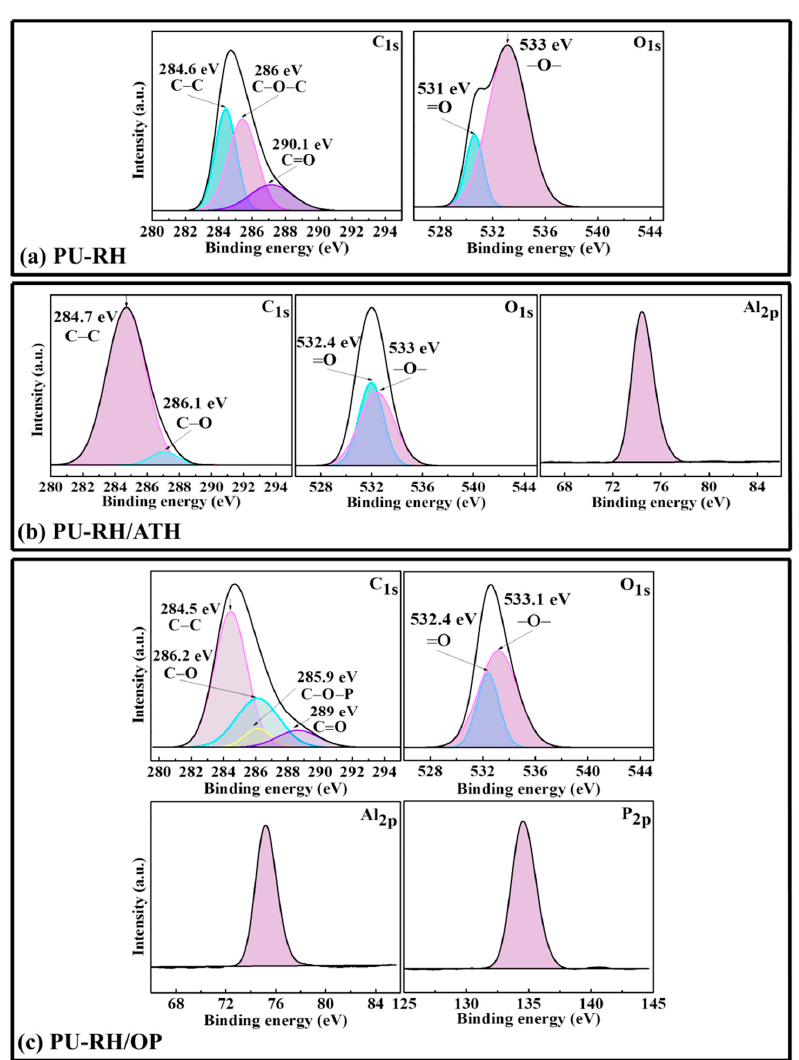
Figure 9. C 1 s , O 1 s , Al 2 p , and P 2 p XPS of the residual chars after the cone calorimetry of ( a ) PU–RH, ( b ) PU–RH/ATH, and ( c ) PU–RH/OP. ( b ) PU–RH / ATH, and ( c ) PU–RH /